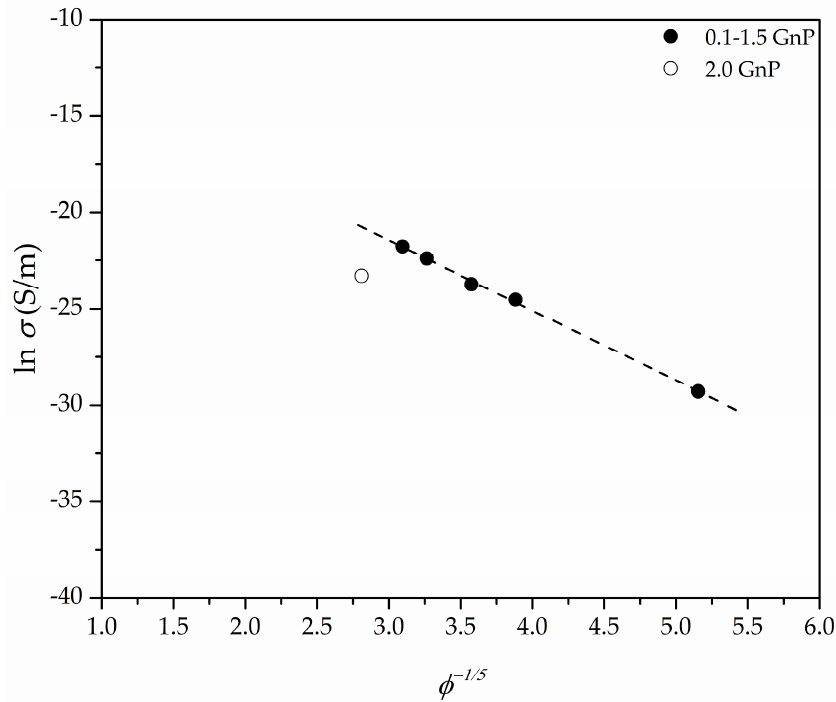
Figure 9. Representation of the fitting results of the electrical conductivity versus φ − 1/5 , demonstrating the tunnel conduction characteristic of a 3D random particle distribution system formed by conductive GnP nanoparticles.